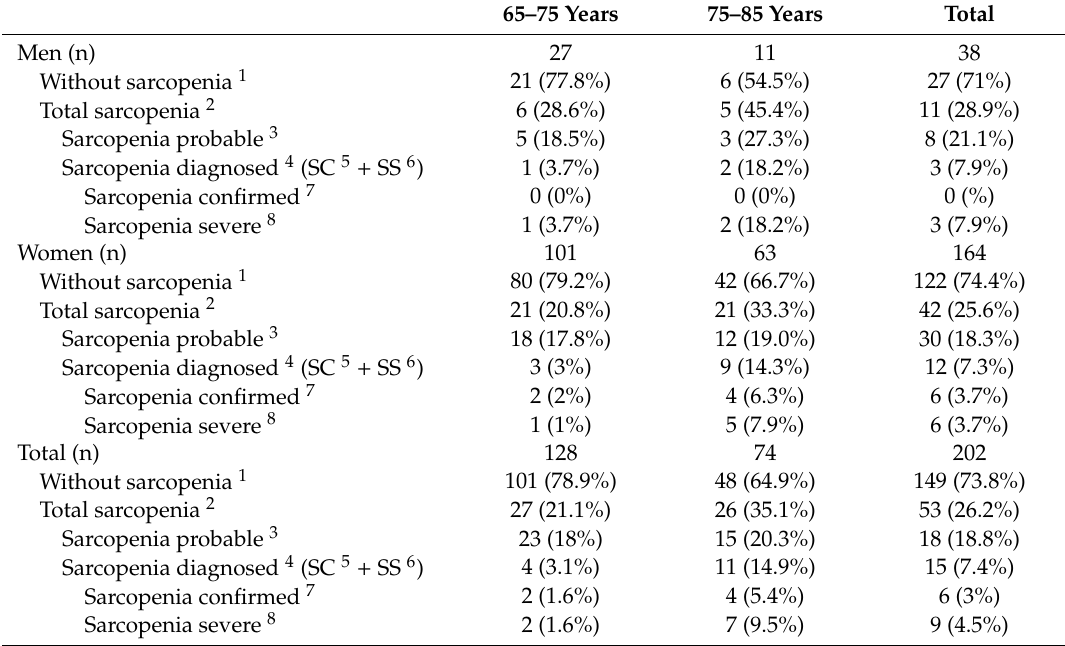
Table 1. Prevalence of sarcopenia in community-dwelling older adults by EWGSOP2 diagnosis criteria.